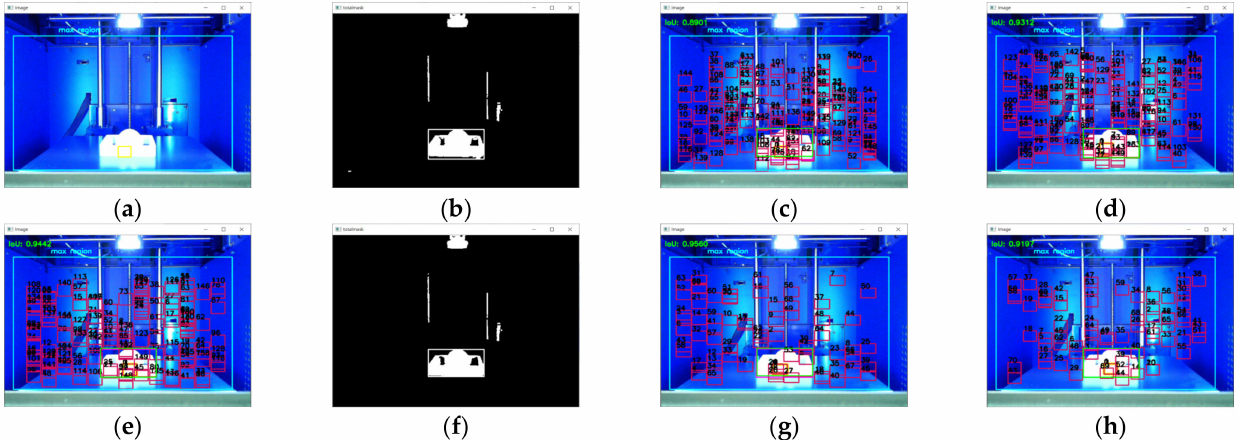
Figure 13. Test 3 product result of proposed algorithm: ( a ) reference ROI for auto color picking; ( b ) final mask binarization image after merge operation (random sampling ROI: 150); ( c ) Test 3 product result (random sampling ROI: 150); ( d ) another Test 3 product result (random sampling ROI: 150); ( e ) another Test 3 product result (random sampling ROI: 150); ( f ) final mask binarization image after merge operation (random sampling ROI: 70) of another Test 3 product in Figure 12g; ( g ) another Test 3 product result (random sampling ROI:70); ( h ) another Test 3 product result (random sampling ROI:70).